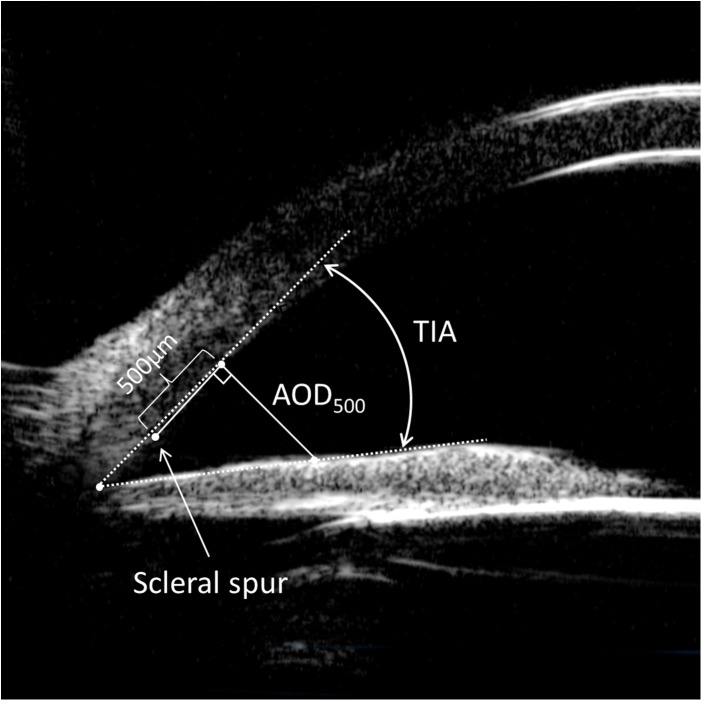
Measurement of the angle on the ultrasound biomicroscopy image of the anterior segment.Angle-opening distance at 500 μm (AOD500) was measured on a line perpendicular to the trabecular meshwork at points 500 μm from the scleral spur. Trabecular-iris angle (TIA) was measured with the apex in the iris recess and the arms of the angle passing through a point on the trabecular meshwork 500 μm from the scleral spur and the point on the iris perpendicularly opposite.